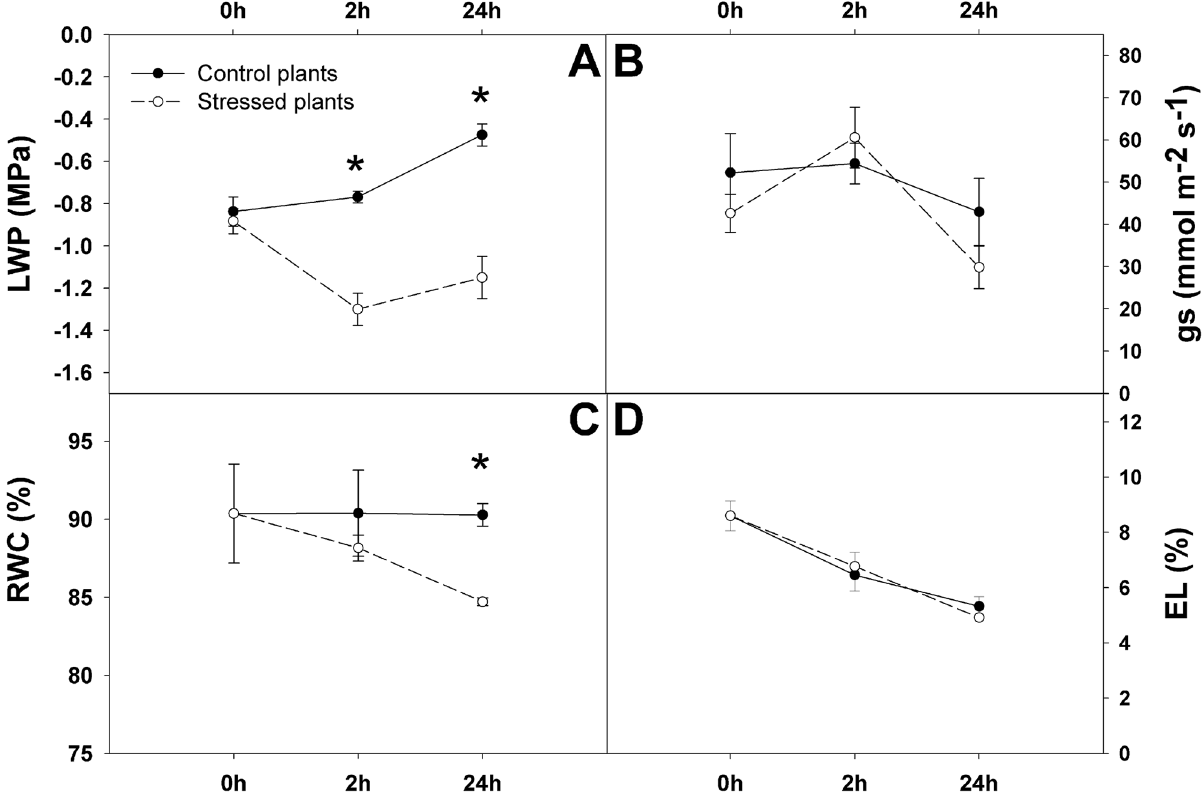
Fig 1. Leaf water potential (LWP) (A), stomatal conductance (gs) (B), relative water content (RWC) (C) and electrolyte leakage (EL) (D) during the drought experiment for control and treated plants of ‘Garnem’. Continuous lines indicate well-watered plants, while dash lines indicate stressed plants. (h = hours. Error bars represent the standard error of the mean. Asterisks represent significant differences (p (cid:20) 0.05) between treatments (control and stressed) for each time point of the experiment.